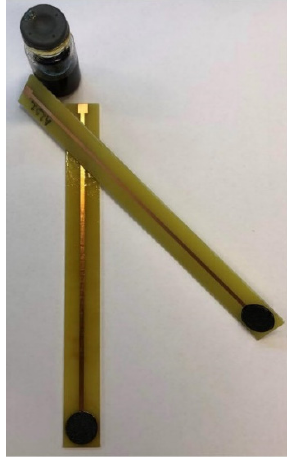
Figure 4. Digital photography of Electrode Body 2 (EB2).